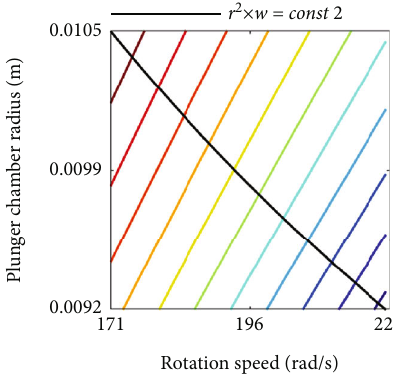
Figure 5: The projected contour plot of the variable pressure drop on the r × w term c 6